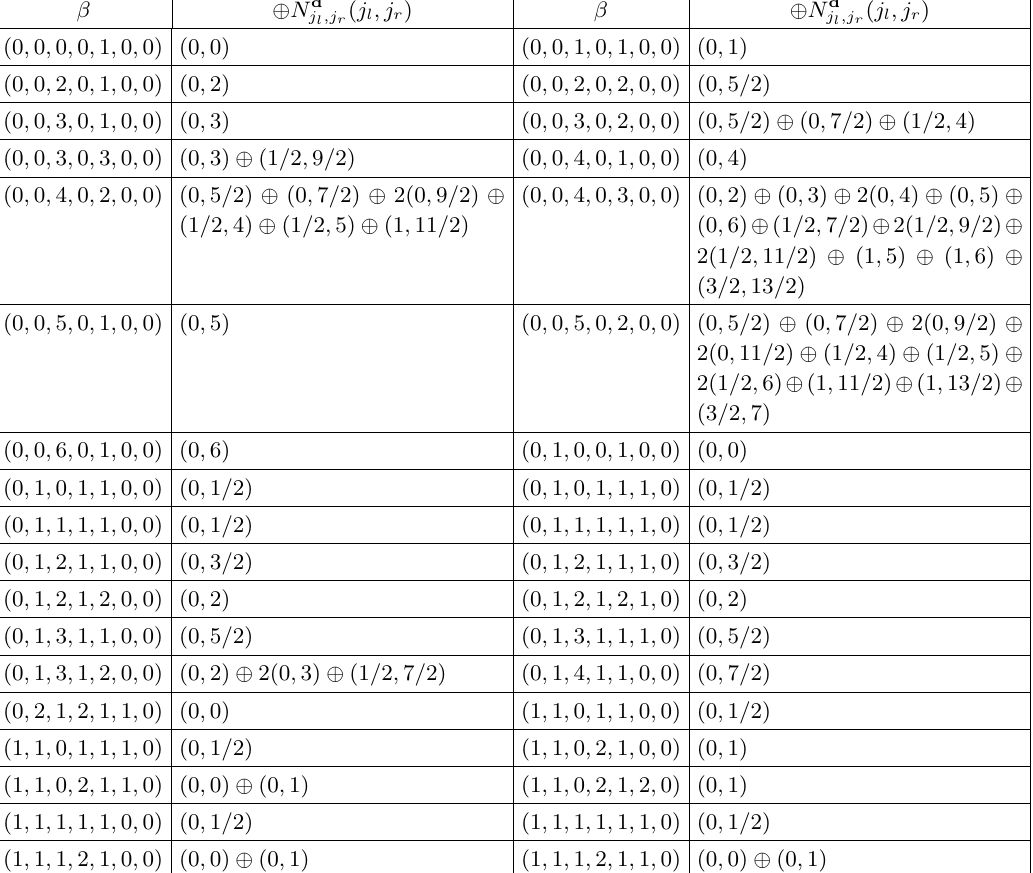
Table 22 . Refined BPS invariants of 6d n = 3 , G 2 model, with a su (2) mass turned on.